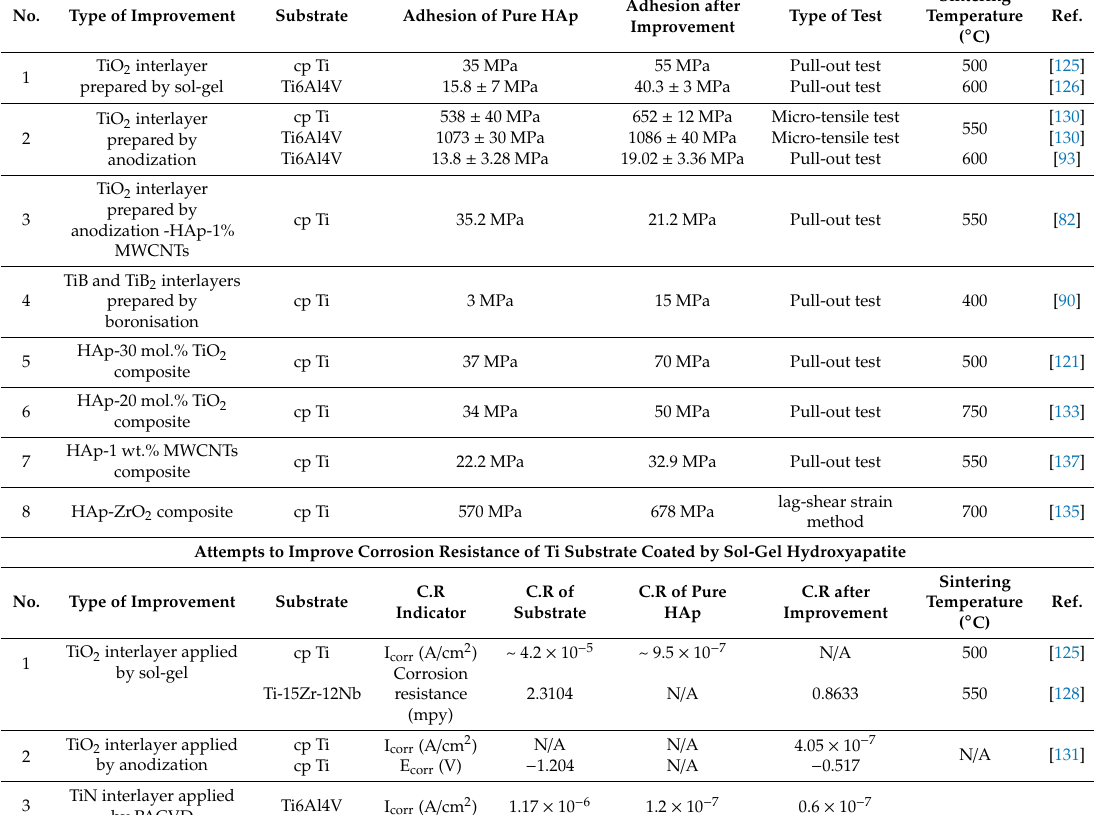
Table 4. Summary and comparison of the adhesion and corrosion resistance improvements of sol-gel derived HAp coatings on Ti